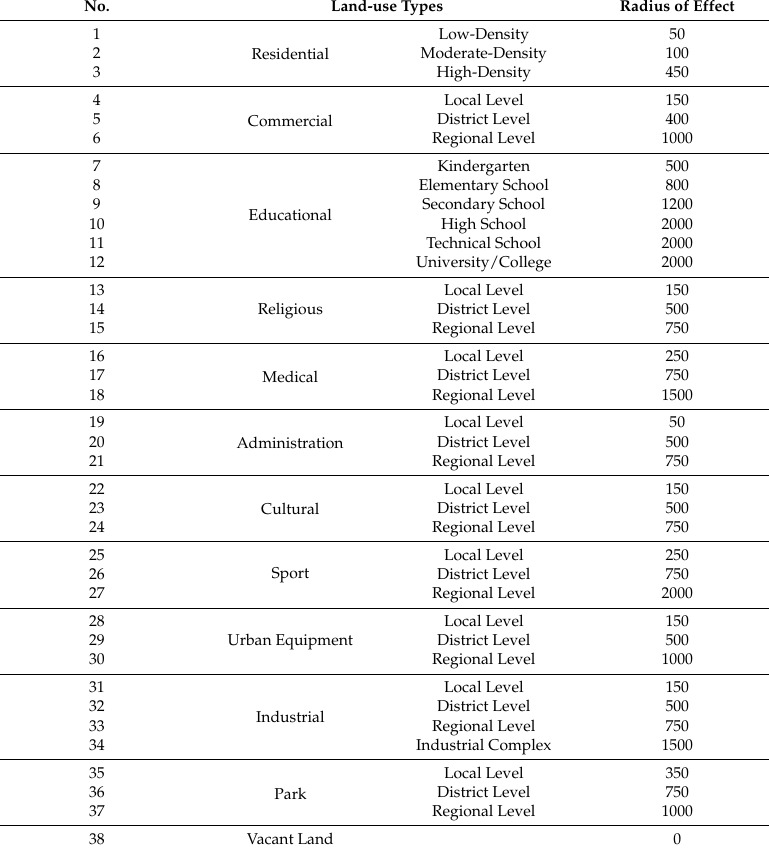
Table A1. Land-use types and their radius of effects